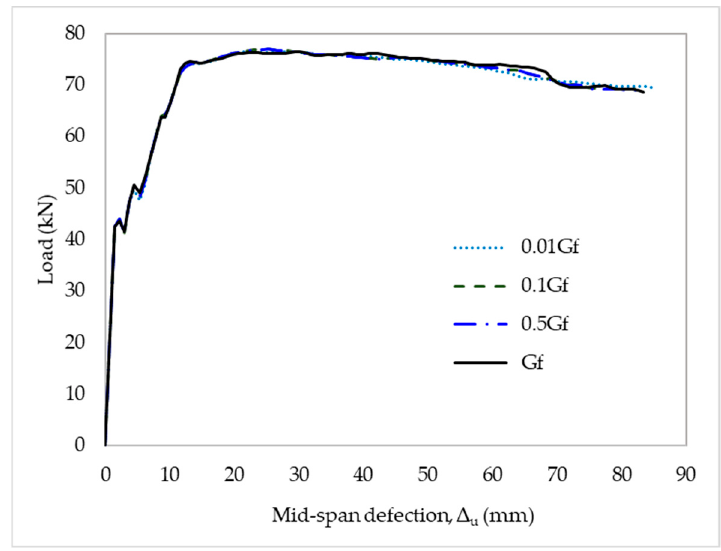
Figure 12. Sensitivity to fracture energy of CFRP ‐ to ‐ concrete interface.